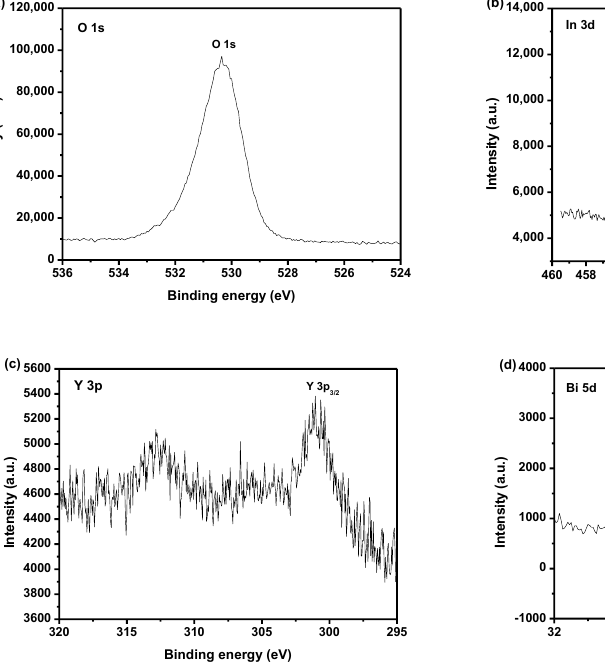
Figure 10. XPS survey spectrum of the IBHP.